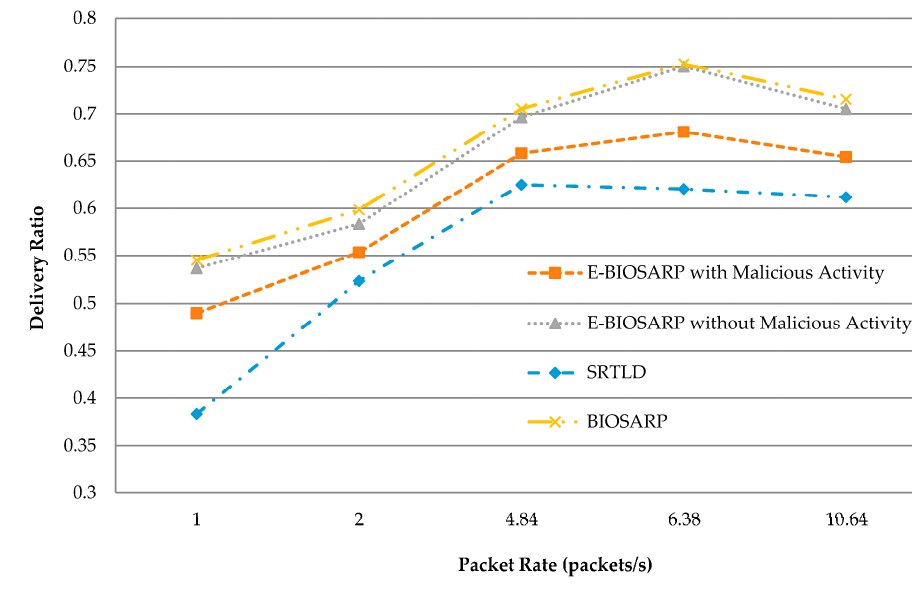
Figure 11. Delivery ratio comparison. Table 6. Delivery ratio